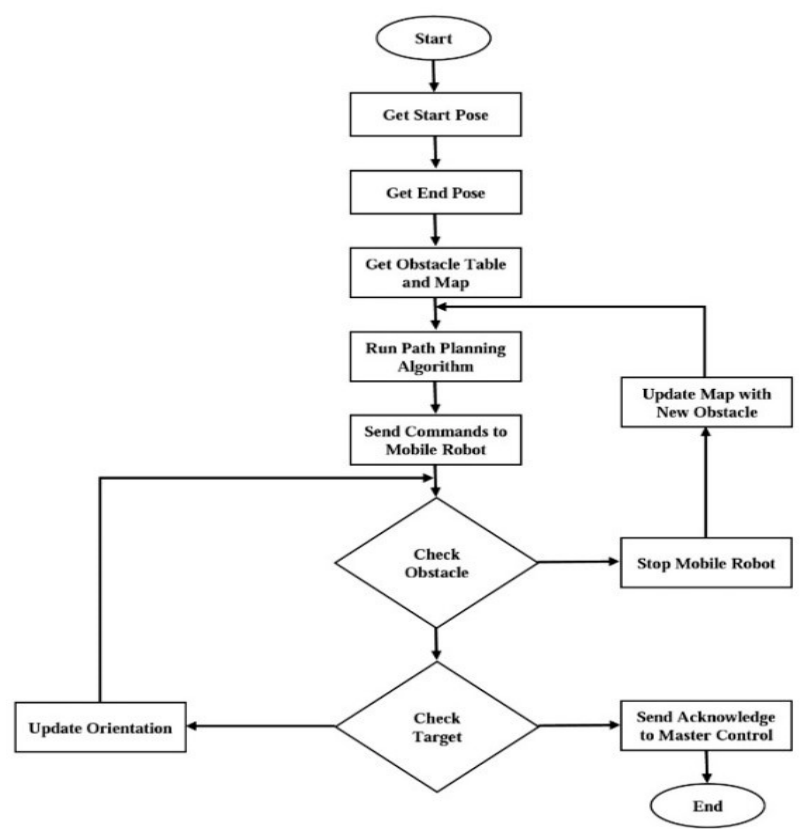
Figure 3. A flowchart that shows the implementation of the intended path planning algorithm on the